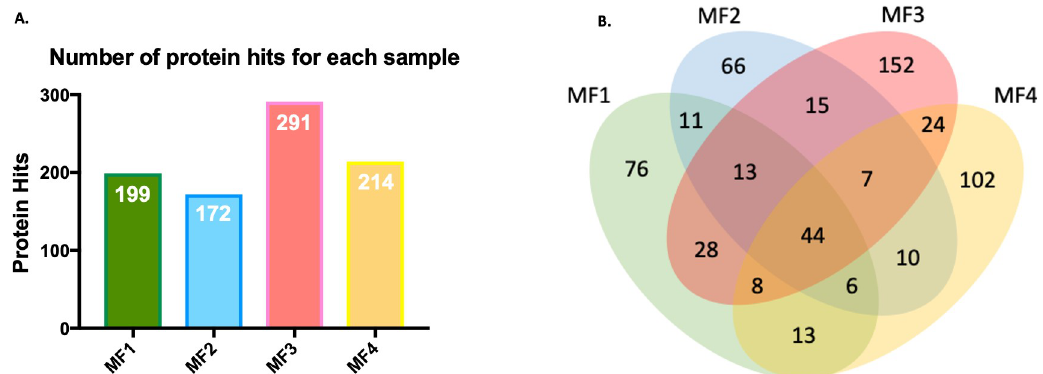
Fig 2. Proteomic characterization of mf-derived EVs. Four mf-derived EV samples were prepared for liquid chromatography- tandem mass spectrometry. The proteomic analysis revealed several parasite proteins. The total number of identified filarial proteins differed slightly between the EV preparations (A). Proteomics results for each EV sample was assessed in order to determine overlapping protein hits (B).